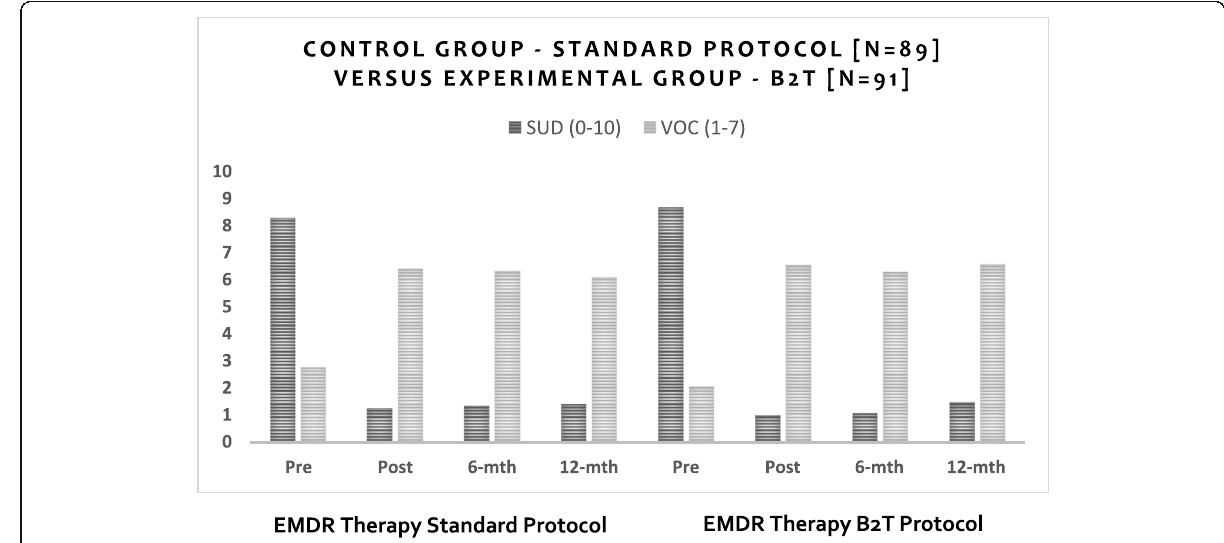
Fig. 2 EMDR Therapy Standard Protocol ( N = 89) versus Blind 2 Therapist Protocol ( N = 91) SUD and VOC scores pre-, post- and 6 months